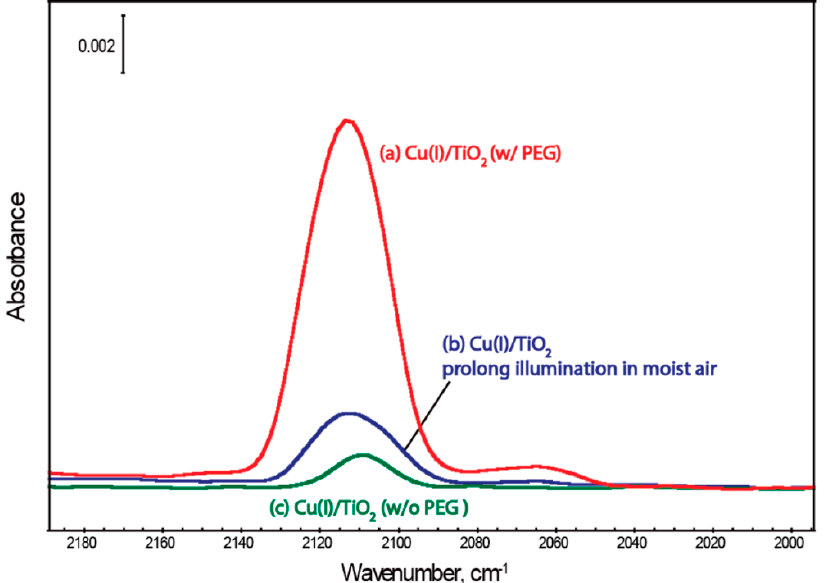
Figure 1. Fourier Transform Infrared Spectroscopy FTIR spectra of Cu(I)/TiO 2 preloaded with 13 CO 2 after 80-min illumination. ( a ) fresh Cu(I)/TiO 2 (synthesized with PEG), ( b ) Cu(I)/TiO 2 cleaned by illumination in humid air for 14 h, and ( c ) reference Cu(I)/TiO 2 (synthesized without polyethylene glycol (PEG)), reproduced with permission from reference [4]. Copyright American Chemical Society, 2010.